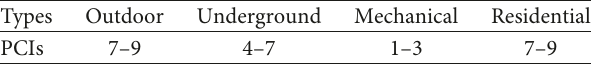
Table 3: PCIs of different types of parking lots.